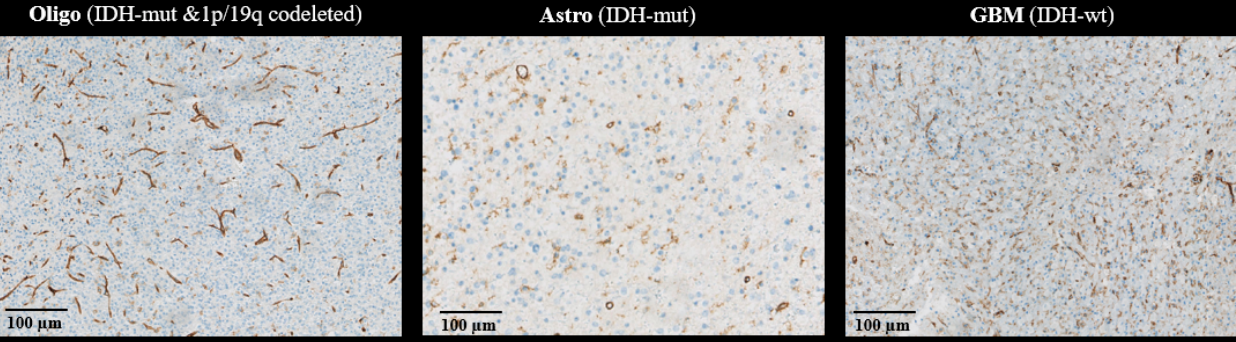
Figure 5. Exemplary CD31-stained tissue of three patients with Oligo (IDH-mut &1p/19q co-deleted), Astro (IDH-mut), and GBM (IDH-wt), from left to right.